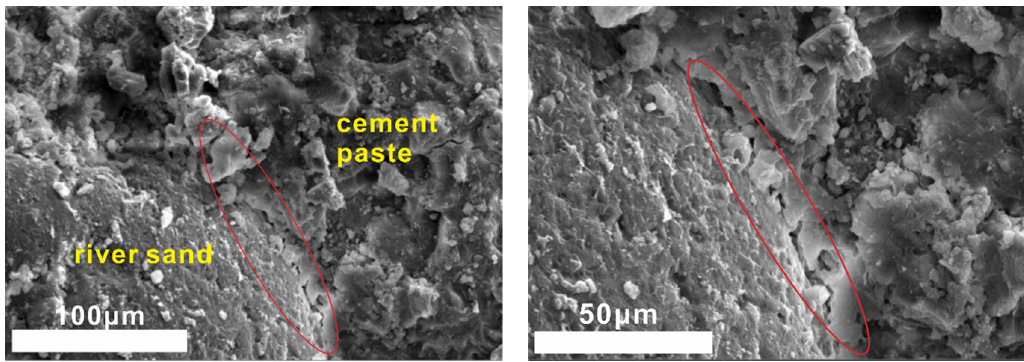
Figure 12. SEM images of samples hydrated for 28 days with steel slag sand as the aggregate. Molecules 2020 , 25 , x